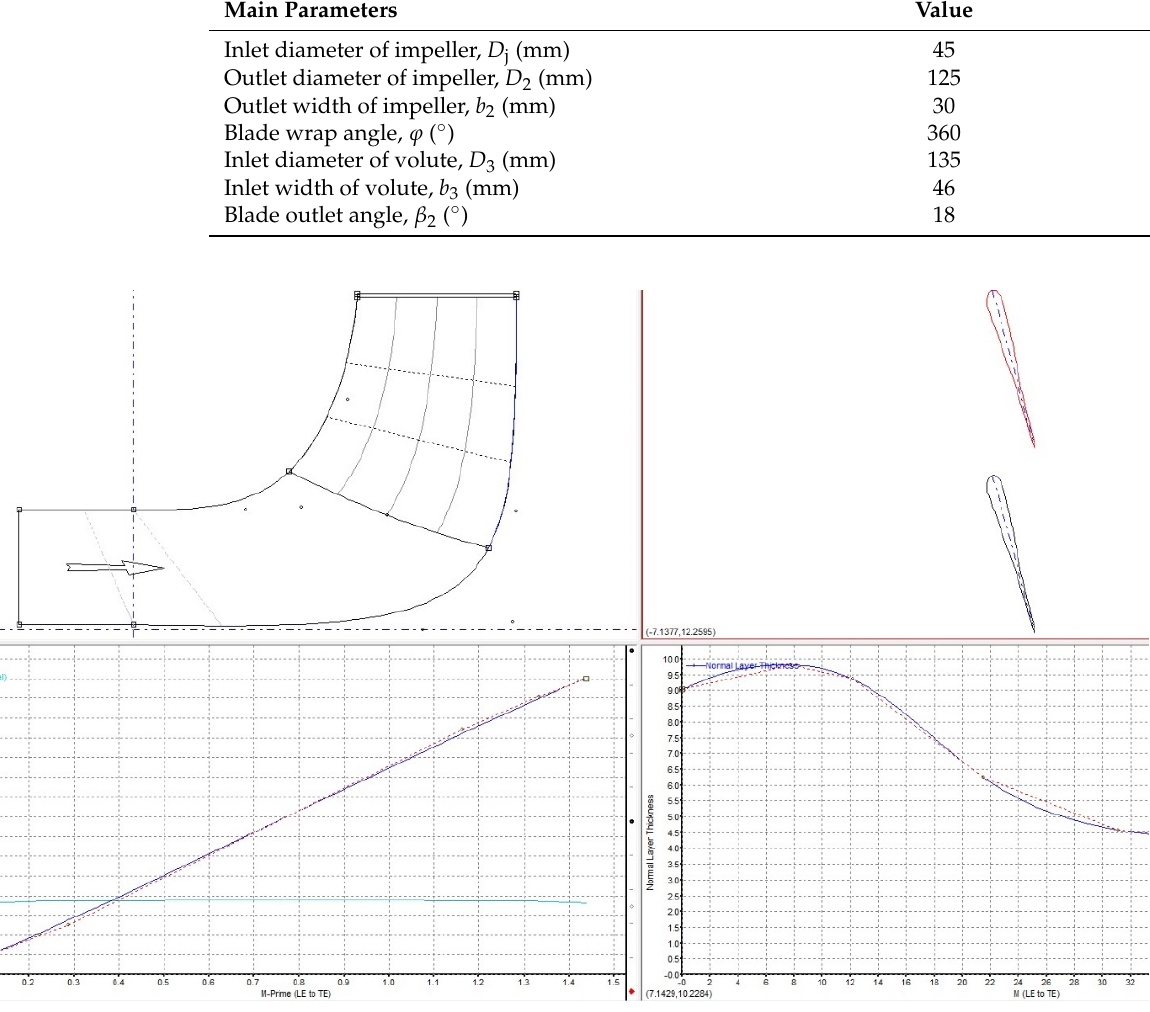
Figure 1. Design process of single blade centrifugal impeller by Bladegen.